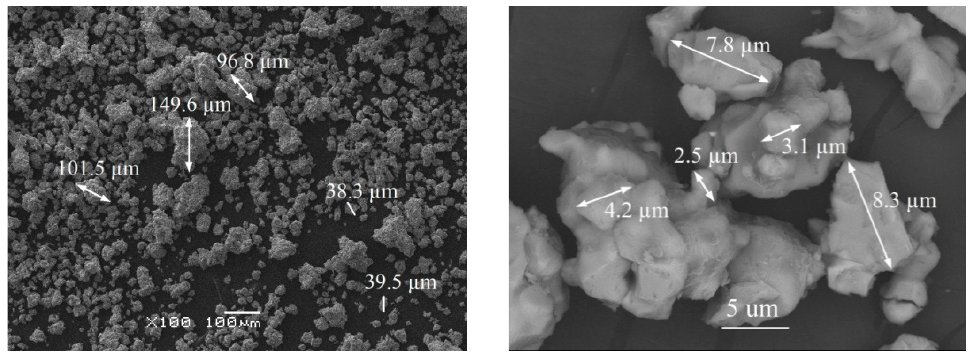
Figure 2. SEM images of LMG-Ho 3+ .